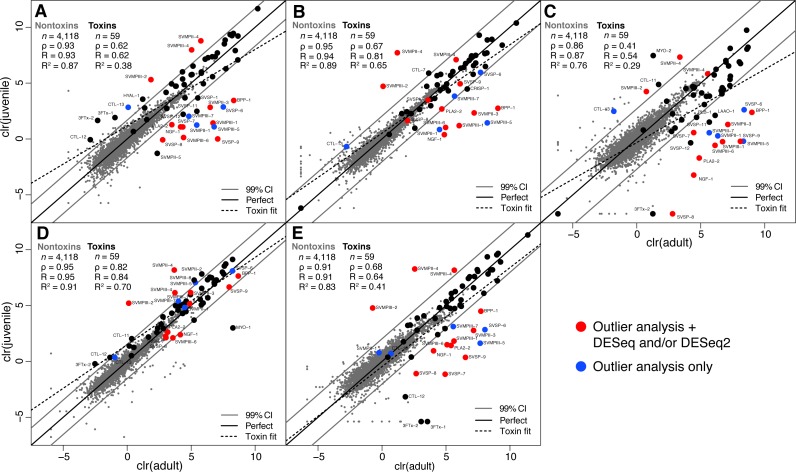
Adult/juvenile expression comparisons identified 17 differentially expressed toxin transcripts.Nontoxin expression comparisons were used to establish a null distribution and 99% confidence interval for differences for each of five comparisons. Transcripts indicated by blue dots were those detected as outliers with expression differences in the same direction in at least three of five comparisons. Transcripts indicated with red dots were also detected as differentially expressed by DESeq and/or DESeq2 (Table 5). (A) Apalachicola National Forest (ANF). (B) Brooksville Ridge (BR). (C) Caladesi Island (CAL). (D) Everglades National Park (ENP). (E) Little St. George Island (LSG). Abbreviations: clr, centered logratio; n, number of transcripts; ρ, Spearman’s rank correlation coefficient; R, Pearson’s correlation coefficient; R2, coefficient of determination.